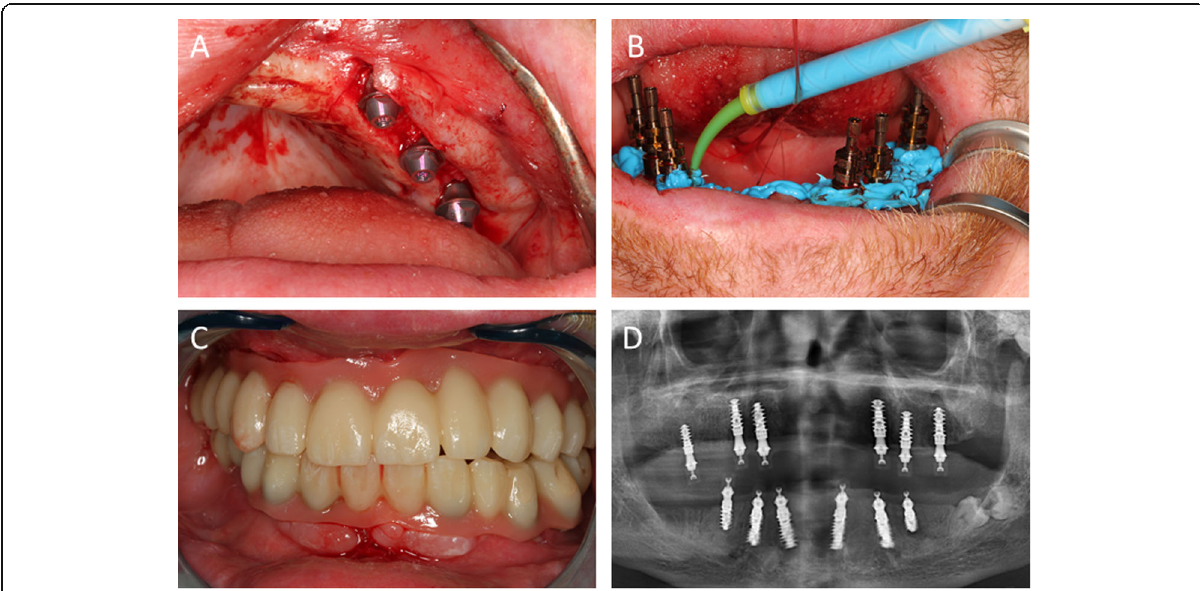
Fig. 5 a The implants are restored with abutments for screw-retained FDPs. b An impression of the area being taken after suturing. c The fixed long-term provisional dental prostheses placed with screws 10 h after implantation. d A radiographical control image obtained after